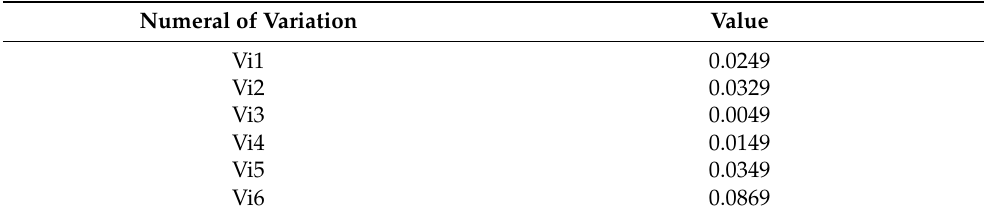
Table 5. Intermediate results of the statistical variation (V).